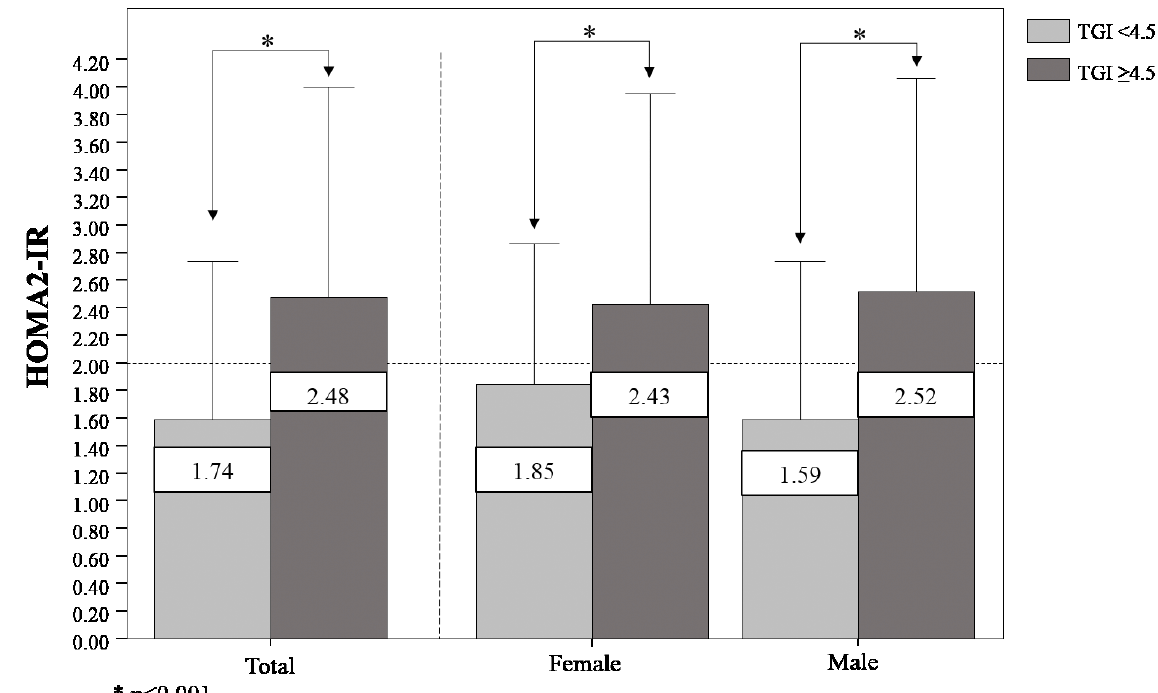
Figure 3. HOMA2-IR levels according to the specific cutoff point for the triglyceride-glucose index in the general population, in Maracaibo city,